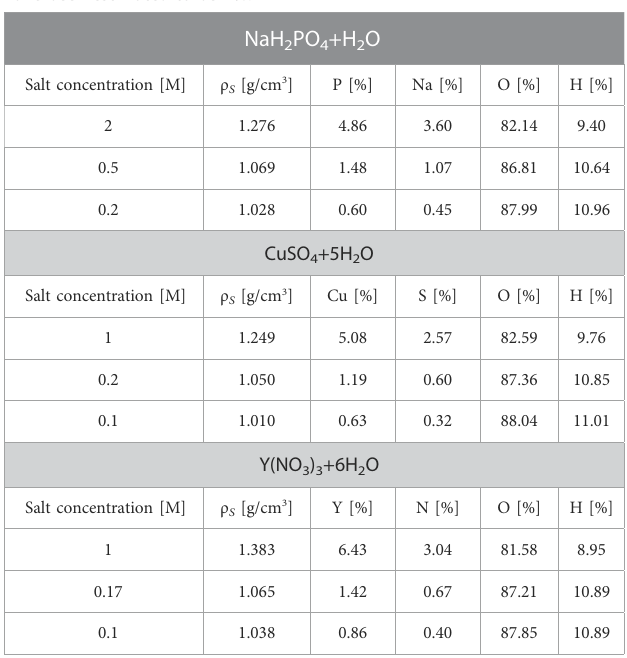
The PG production of all candidate materials was measured using both solid and liquid targets, irradiated at the two facilities with the setups shown in Figure 2. As a solid target, we used a 63 Cu cylindrical rod of 9.5 mm diameter and 30 mm height both at TPC and at Cyrcé.